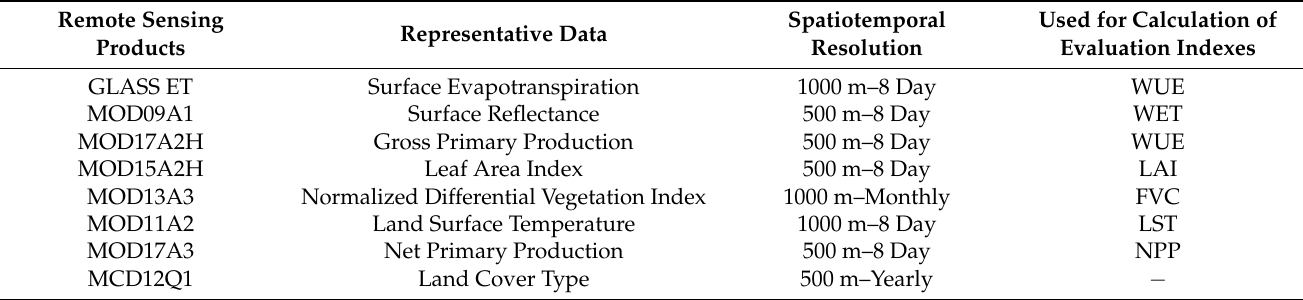
Table 1. Remote sensing products used for the